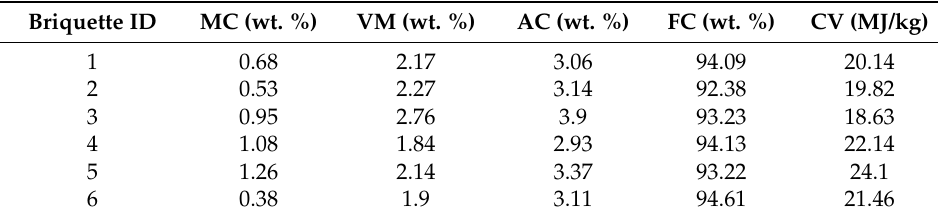
Table 4. Proximate Analysis of Briquettes Samples